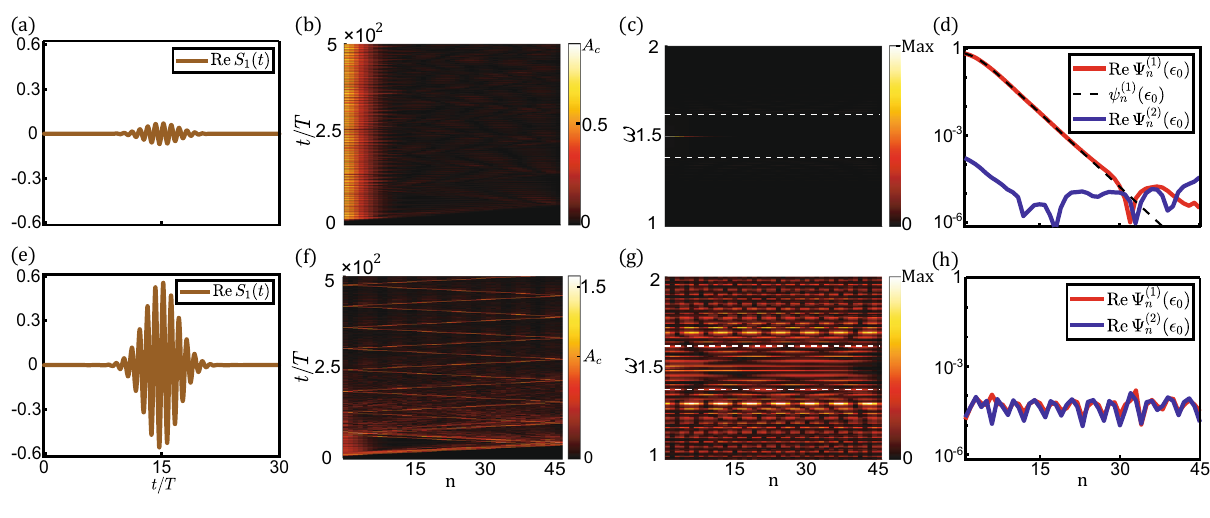
Fig. 2 Nonlinear edge excitations of the model subjected to T-to-N transition, where the parameters ful fi ll c 1 < c 2 and d 1 > d 2 . a – d and e – h show lattice boundary responses in small-amplitude topological regime and large-amplitude nontopological regime, respectively. The magnitudes of Gaussian tone bursts are S = 7 × 10 − 2 in (a) and S = 56 × 10 − 2 in ( e ), respectively. ( b ) and ( f ), spatial-temporal pro fi les of j R e Ψ ð 1 Þ n ð t Þj for all 45 sites, where j R e Ψ ð 1 Þ n ð t Þj denote the strength of the lattice excitations. ( c ) and ( g ), spatial pro fi les of the frequency spectra of the responding modes, where the time domain of performing Fourier analysis is from 250 T to 500 T . White dashed lines mark the top and bottom of the linear band gap. In ( g ), modes in the band gap are triggered by energy absorption 54 from nonlinear bulk modes. ( d ) and ( h ), red and blue curves for the spatial pro fi les of the ω = ϵ 0 wave component of the Þ is depicted by the black dashed curve in ( d excitations. The analytic prediction of the topological mode ψ ð 1 Þ n ð ϵ 0